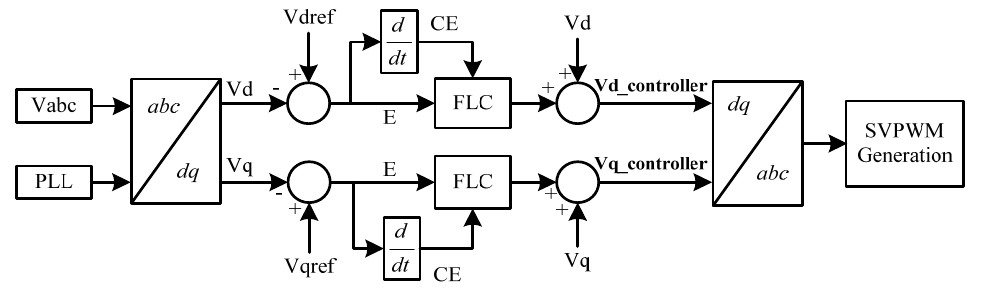
Figure 2. Inverter voltage control with FLC.